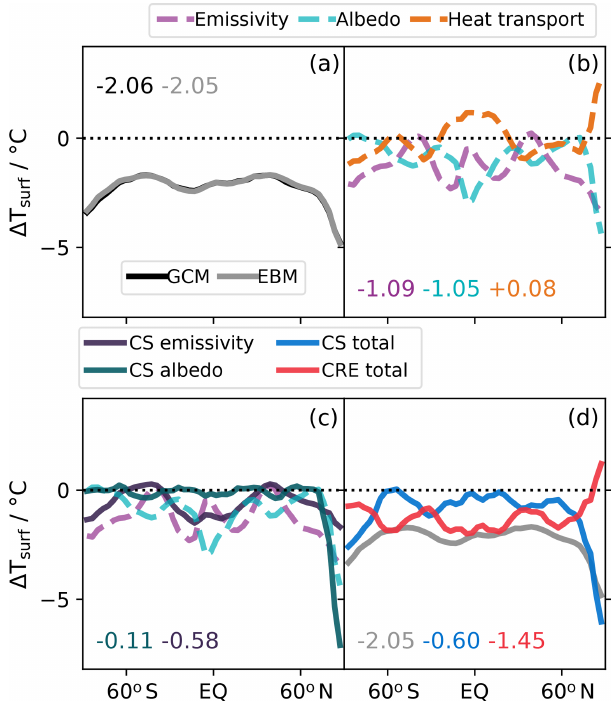
Figure 16. 1-D energy balance decomposition analogous to Fig. 7 for the 21%–10% O 2 Poulsen et al. (2015)